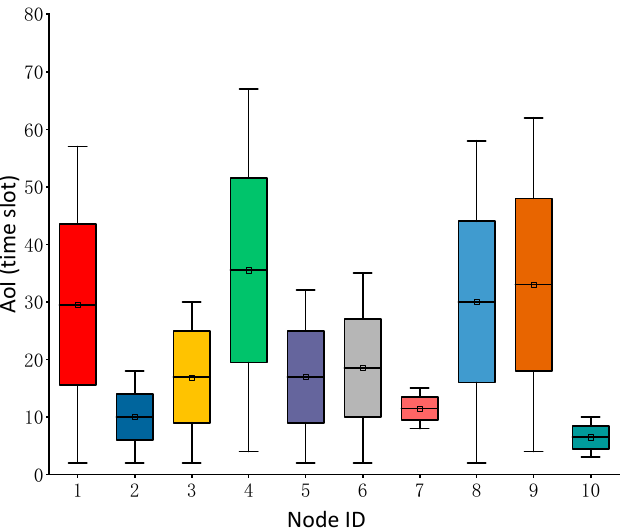
Figure 5. Boxplot of AoI for all ten sensor nodes.